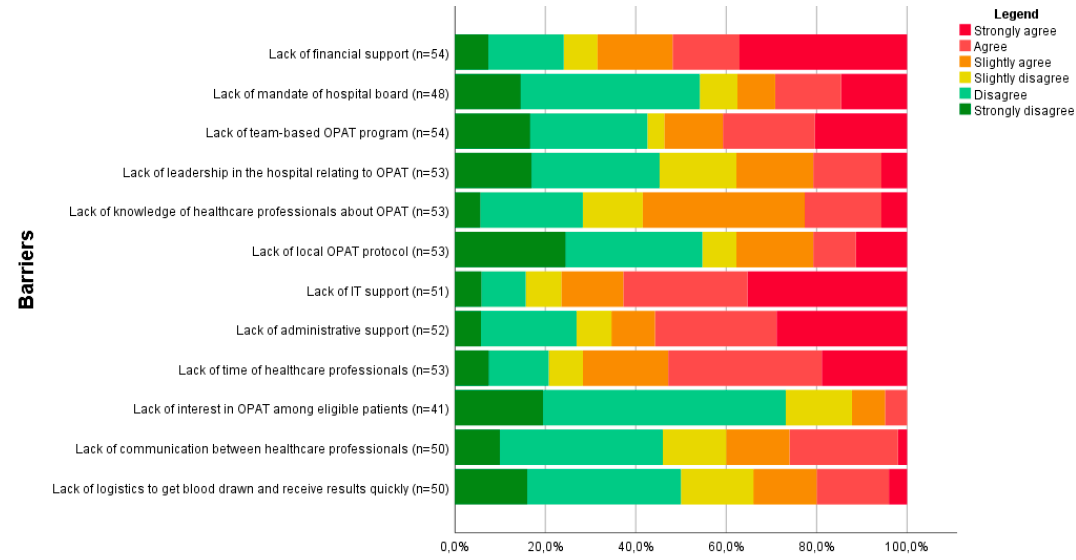
Figure 2. Barriers to OPAT care experienced by OPAT performing hospitals ( n = 55) a . a The value ‘Do not know’ was considered as missing, resulting in different denominators per barrier.